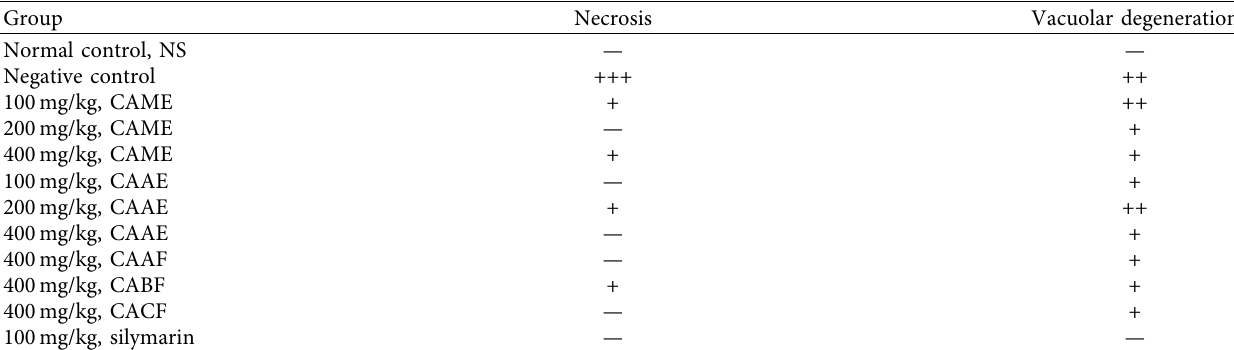
Table 4: Effects of different doses of crude extracts and solvent fractions of the methanol stem bark extracts of C. africana on APAP-induced liver injury.